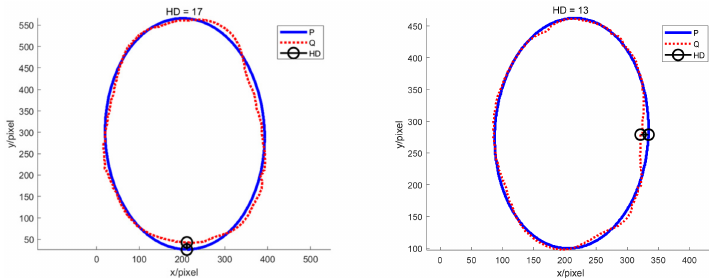
Figure 11. Hausdorff distance calculation results for regular